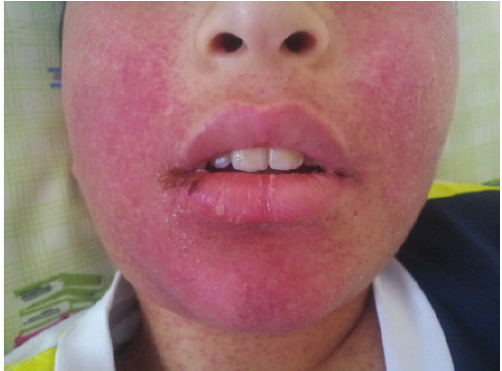
Figure 1: Generalised maculopapular rash, partly confluent to plaques on face.